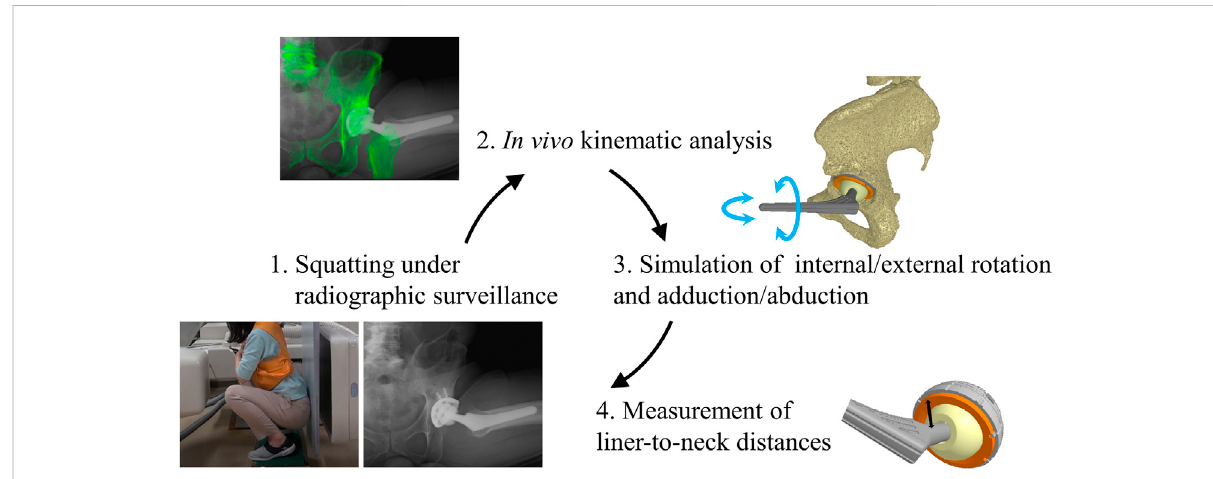
FIGURE 1 Schema represents the concept of this study. (1) Patients who had undergone total hip arthroplasty stood from asquat position with their heels down, and their hip motions were captured using a fl at-panel X-ray detector. (2) The digitally reconstructed radiographs (DRRs) from computed tomography slices were matched to the actual radiographic images to analyze in vivo kinematic data [13]. (3) Computer simulations of the hip internal/external rotation and adduction/abduction were performed using in vivo implant placement and kinematic data to examine prosthetic impingement at maximum hip fl exion and extension during squatting. (4) The minimum distances between the liner and stem neck (liner-to-neck distances) were measured based on three dimensionally (3D) reconstructed images to de fi ne an impingement-free implant